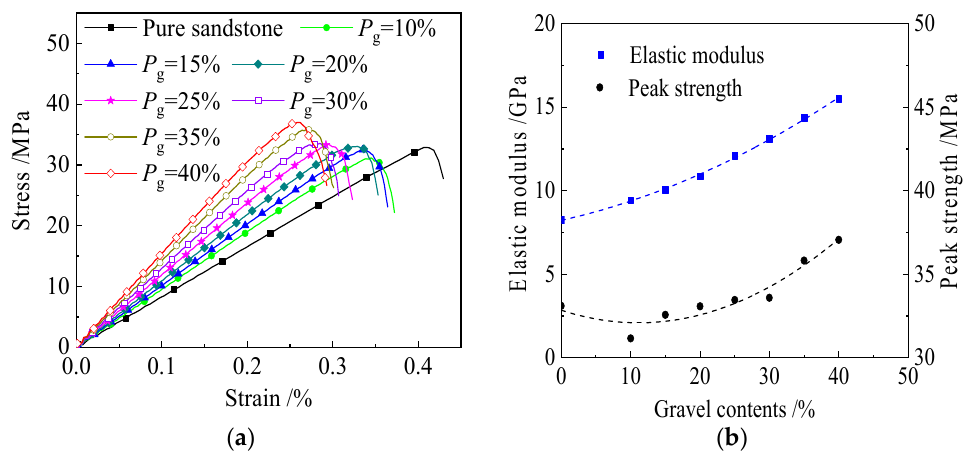
Figure 8. Simulated UCS tests results of DEM pebbled sandstone samples, ( a ) strain–stress plot and ( b ) trend analysis of rock Elastic Modulus and peak strength.